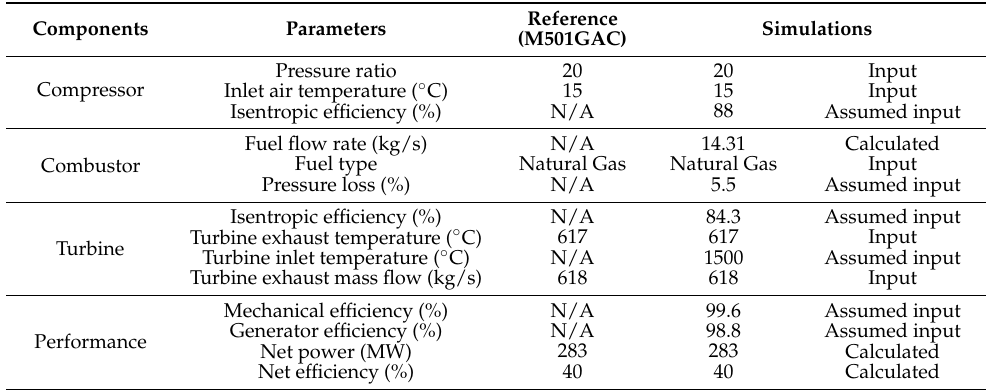
Table 2. Design specifications of the GT [25].